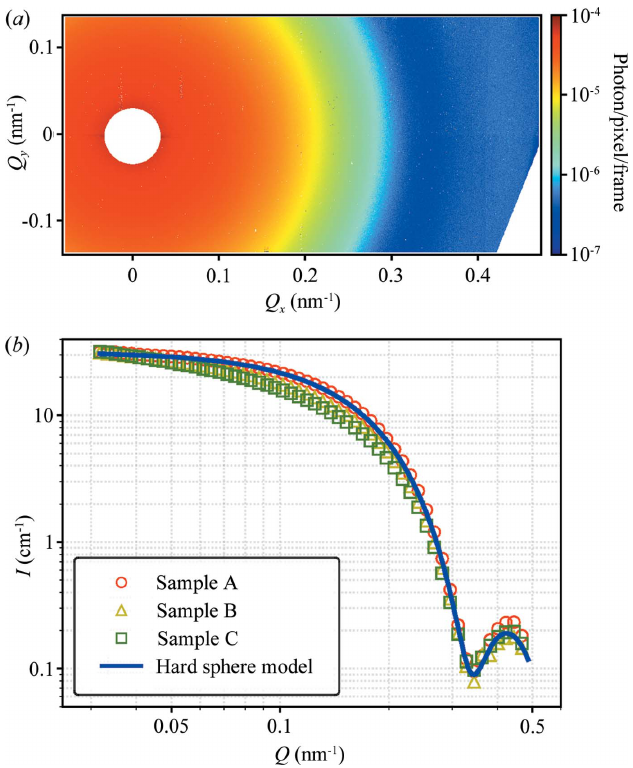
Figure 2 ( a ) SAXS from 9.59 mg ml (cid:2) 1 CPMV suspension in 0.007 M K 3 PO 4 buffer (sample A) averaged over 100000 frames collected continuously within 1.92 s. The result was further averaged from 1000 repeated measurements to improve the statistics. ( b ) Azimuthal average of ( a ) for sample A (red circles), 9.59 mg ml (cid:2) 1 CPMV in 0.007 M K 3 PO 4 and 0.5 M NaCl (sample B, yellow triangle), 9.59 mg ml (cid:2) 1 CPMV in 0.007 M K 3 PO 4 and 0.5 M (NH 4 ) 2 SO 4 (sample C, green square). The solid blue line is the form factor calculated from spherical particles with a Gaussian distribution of the radius (average = 13.0 nm, standard deviation = 1.2